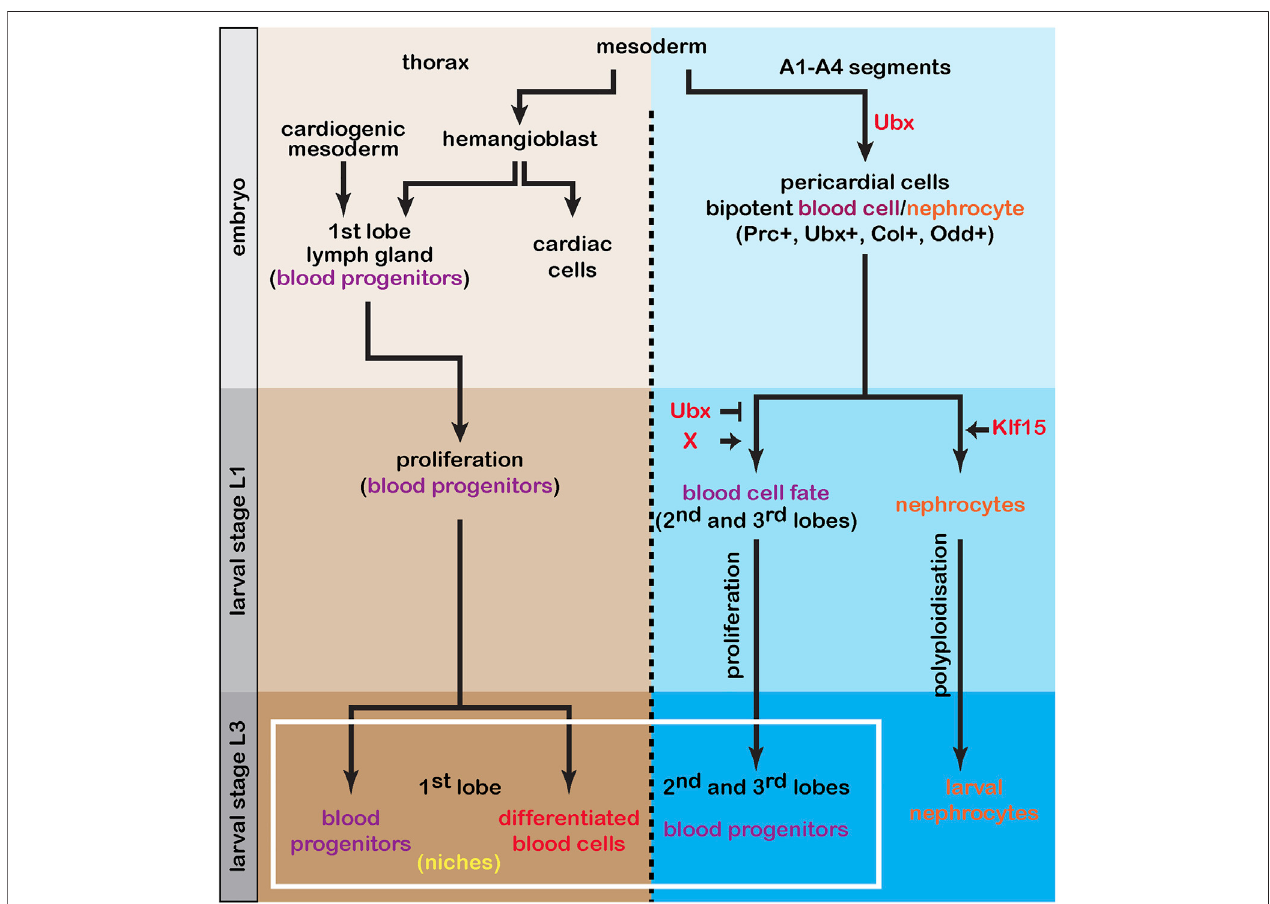
FIGURE6| ThelymphglandisacompositeorganThe fi rstlymphglandlobeoriginatesintheembryofromthecardio-mesoderm andhemangioblast.Attheendof embryogenesis the lymph gland is composed of blood progenitors that will proliferate during larval stage. In third instar larvae, the fi rst lobe is composed of both progenitors and differentiated blood cells. The balance between these two cell populations (homeostasis) is controlled by two niches. During embryogenesis, in A1-A4 segments and depending on Ubx, bi-potent blood cell/nephrocyte progenitors are speci fi ed. At larval stage L1, while larval nephrocytes require Klf15 to form, achievementofthebloodfaterequiresthatbothUbxfunctionbeimpairedandthatastillunknownfactor(X)beinvolved.InL3larvalstage,thesecondandthirdlobesare composedofheterogeneousbloodprogenitors.Inconclusion,thematurelymphglandiscomposedofbloodprogenitorsthathavedifferentoriginsandaregeneratedat two different time points during